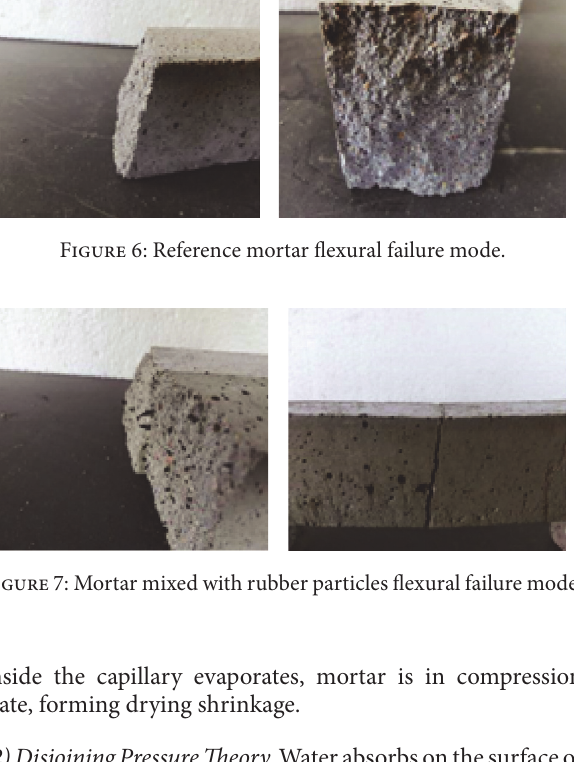
inside the capillary evaporates, mortar is in compression state, forming drying shrinkage.